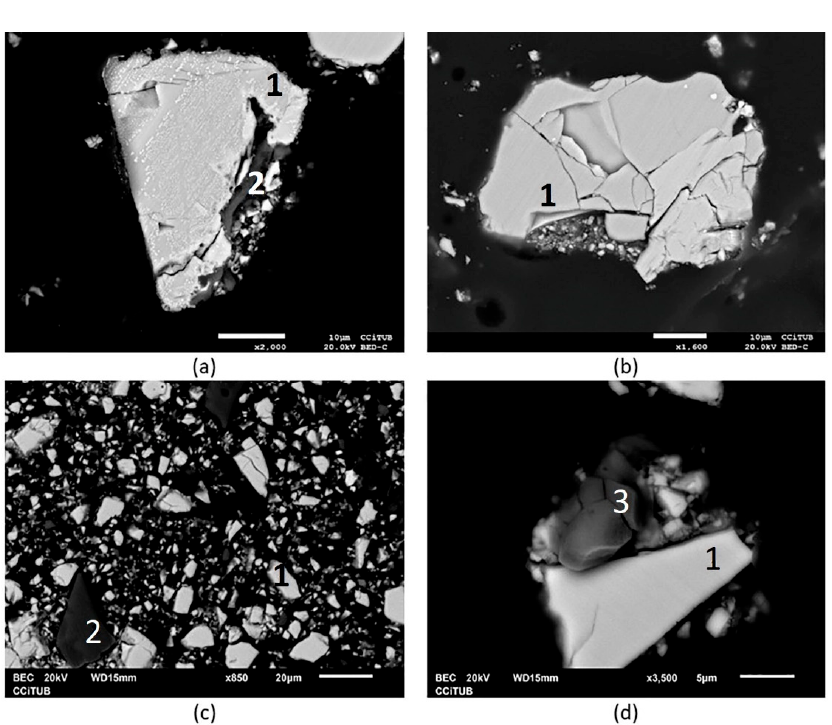
Figure 4. SEM image of the initial sample at various magnifications ( a ) ×2.000, ( b ) ×1.600, ( c ) ×850 and ( d ) ×3500. 1: chalcopyrite, 2: quartz, and 3: copper sulphate (chalcanthite) [36]. and ( d ) × 3500. 1: chalcopyrite, 2: quartz, and 3: copper sulphate (chalcanthite)